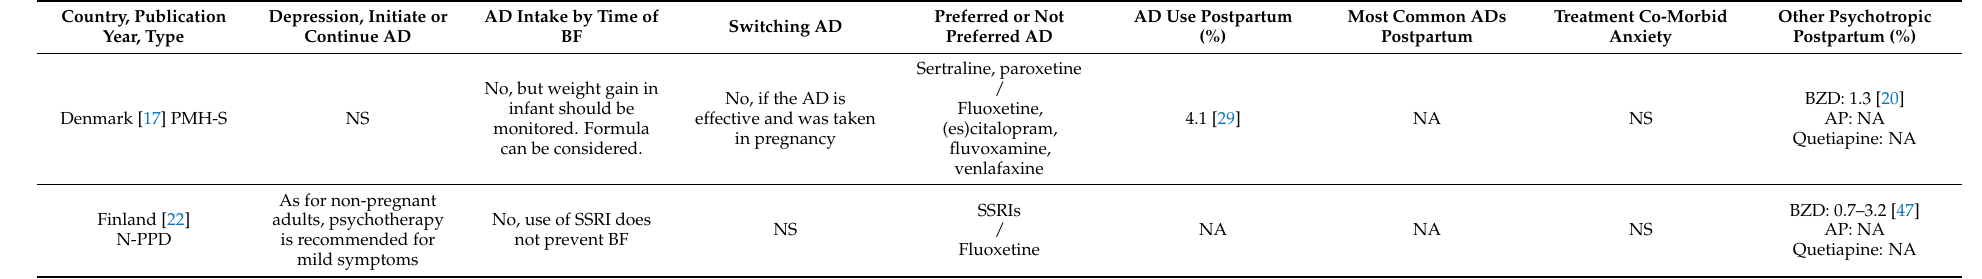
Table 2. Overview of recommendations in the CPGs about antidepressant treatment in women with postnatal depression, with prevalence estimates of antidepressants and other psychotropic medication use in the